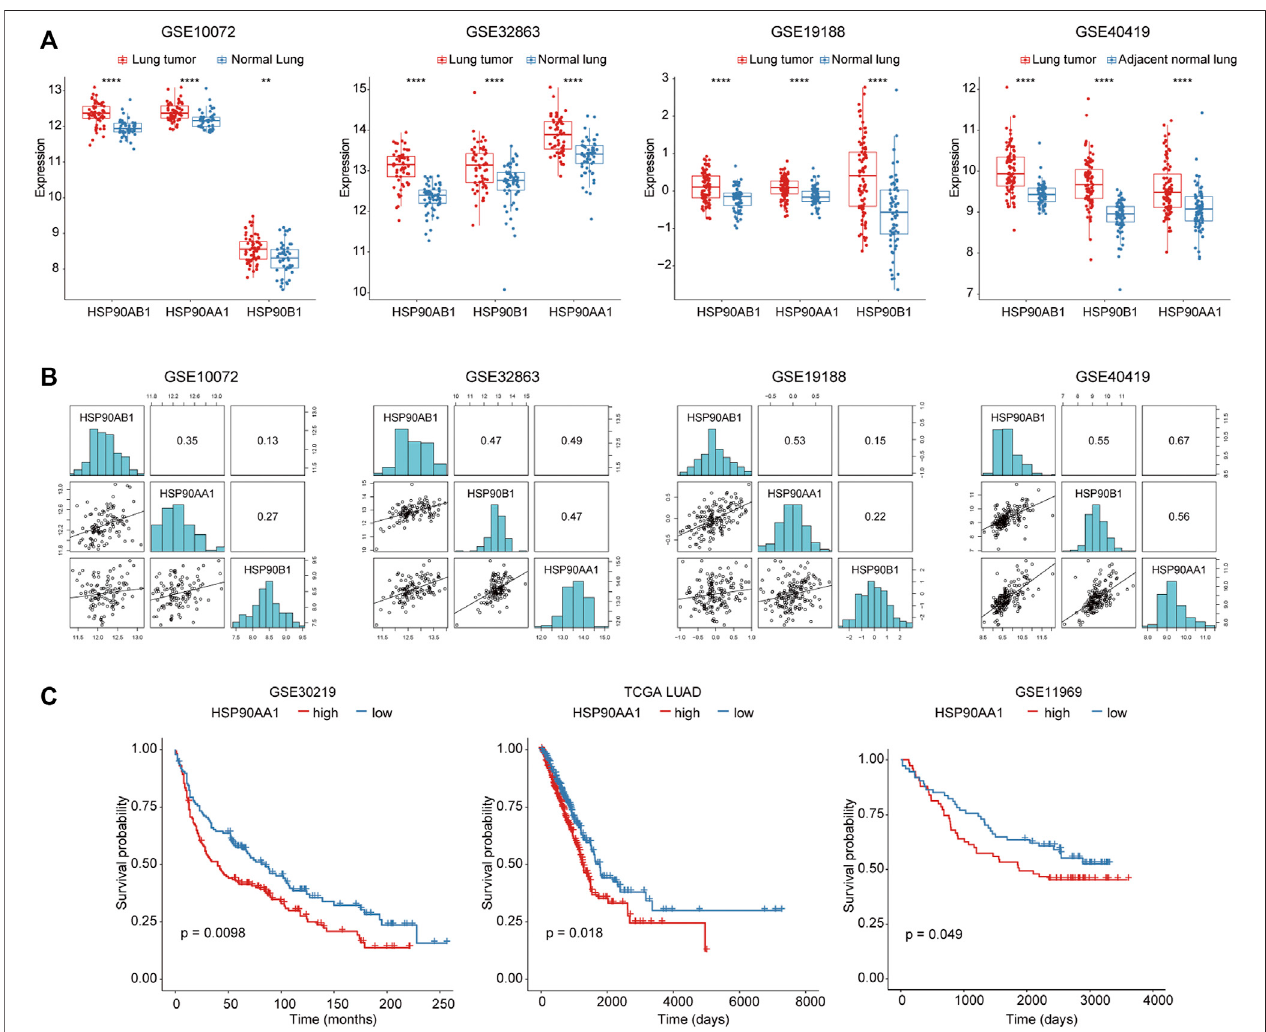
FIGURE 1 | Increased HSP90AA1 is correlated with decreased overall survival time in lung cancer patients. (A) HSP90AA1, HSP90AB1, HSP90B1 are all signi fi cantly up-regulated in lung cancer tissues in four different high throughput datasets. ** p < 0.01, **** p < 0.0001. (B) Three HSP90 isoforms (AA1, AB1, B1) are positively correlated with each other. (C) HSP90AA1 is signi fi cantly correlated with a shortened overall survival time in three datasets.